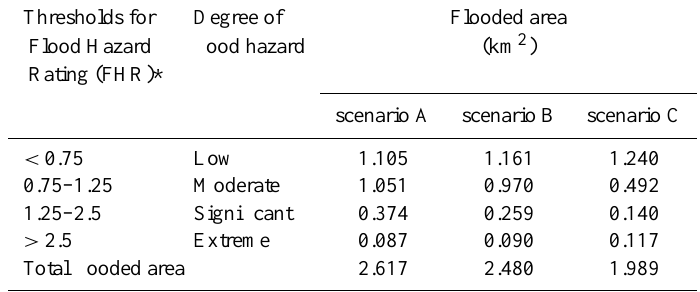
Table 3. Flooded area for different flood propagation scenarios and different flood hazard